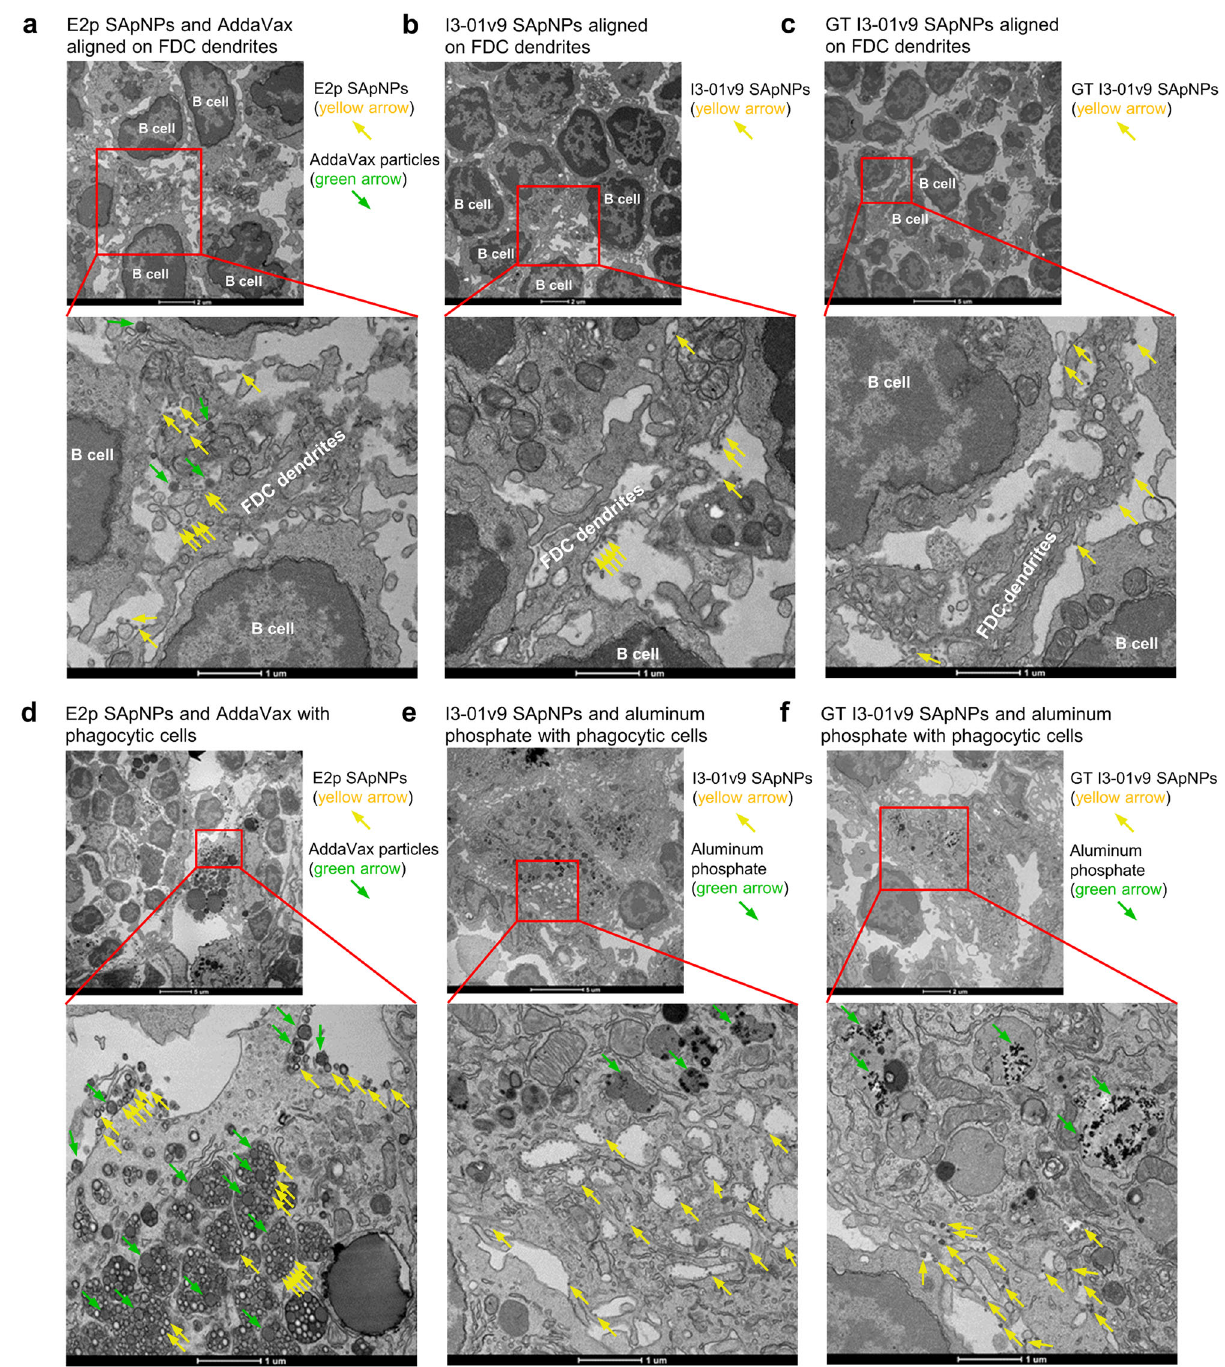
Fig. 9 | Interaction of BG505 UFO trimer-presenting SApNPs with FDCs and phagocytic cells in lymph nodes. a TEM images of E2p SApNPs (yellow arrows) and AddaVax adjuvant (green arrows) presented on the FDC dendrites in a lymph node at 12h after a single-dose injection (2 footpads, 50 μ g/footpad). b and c TEM images of I3-01v9 SApNPs (yellow arrows), wildtype and glycan-trimmed (GT), aligned on FDC dendrites without observable aluminum phosphate (AP) adjuvant at 12h after a single-dose injection. d TEM images of E2p SApNPs (yellow arrows)